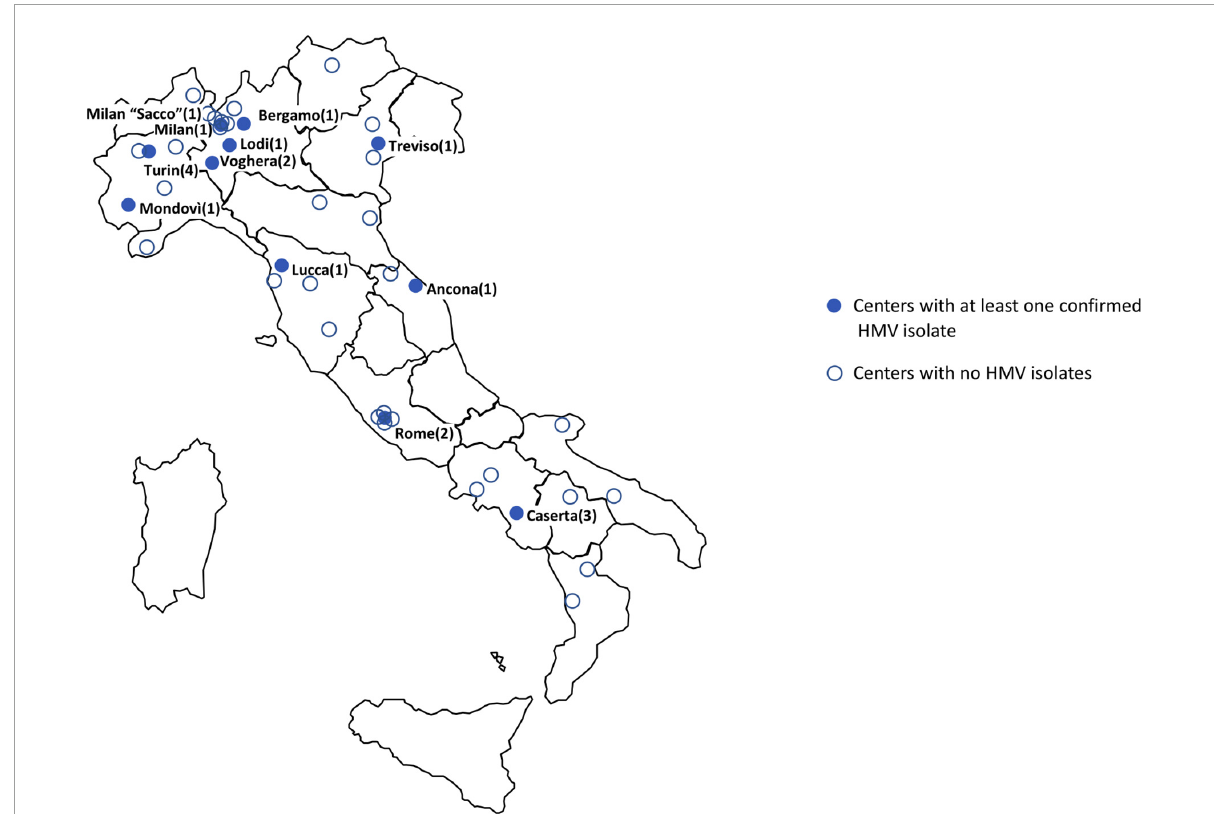
FIGURE1 Geographic distribution of participating laboratories. Blue dots represent centers with at least one HMV isolate. Empty dots represent centers with absence of HMV or non-confirmed HMV isolates only (number of confirmed HMV isolates per center in brackets).